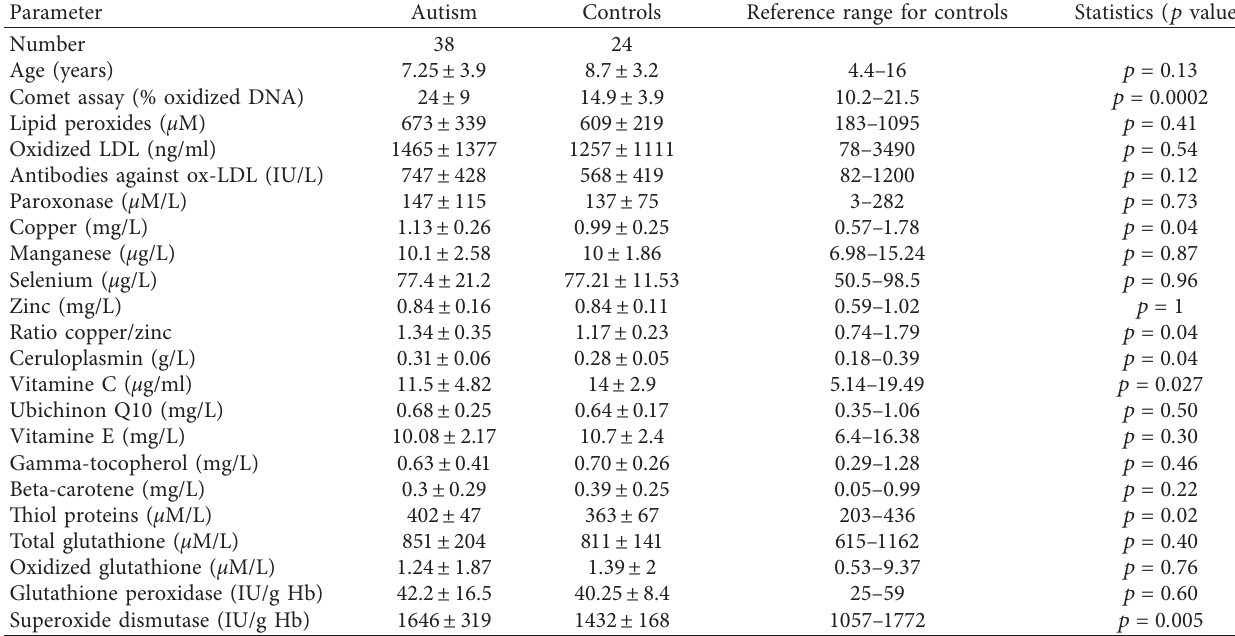
Table 1: Case-control study comparing oxidative stress parameters (mean ± SD) between autistic children and age-matched healthy